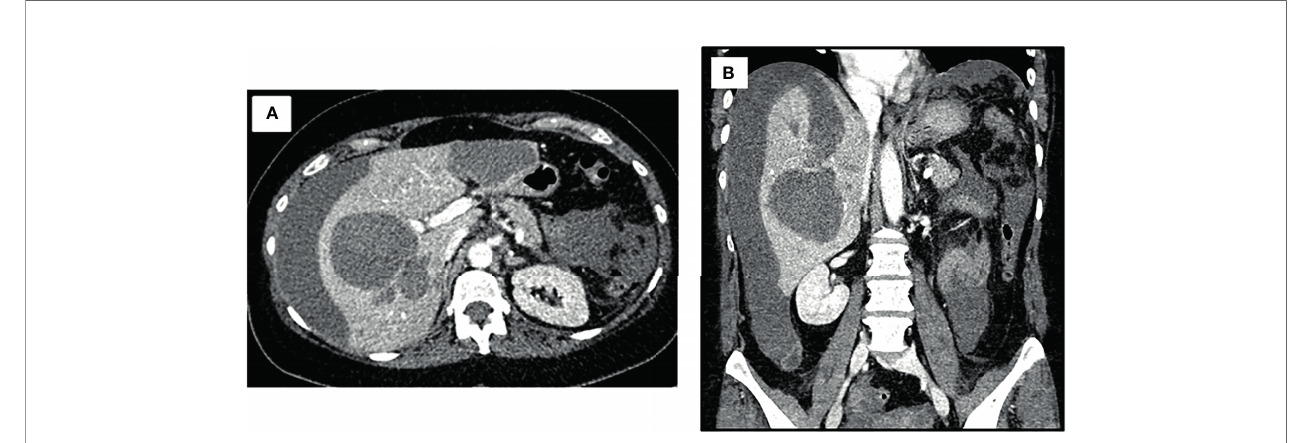
FIGURE 1 | Angio-CT at initial case presentation. Both axial (A) and coronal (B) views revealed two hepatic cystic lesions; one in each hepatic lobule with signs of bleeding at different coagulation stages. The left cystic lesion opened into the hepatic subcapsular space producing a hemoperitoneum, without signs of